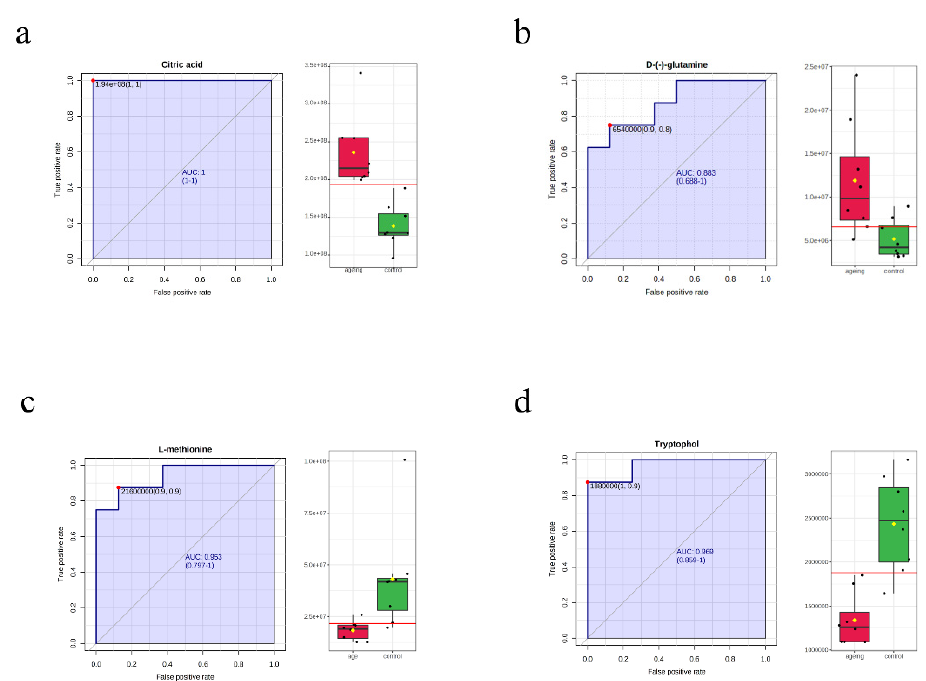
Figure 5. The ROC curve analysis of potential biomarkers (AUC > 0.85) for differentiating the aging group from the control. ( a ) Citric acid, ( b ) D-(-)-glutamine, ( c ) L-methionine, and ( d ) Tryptophol